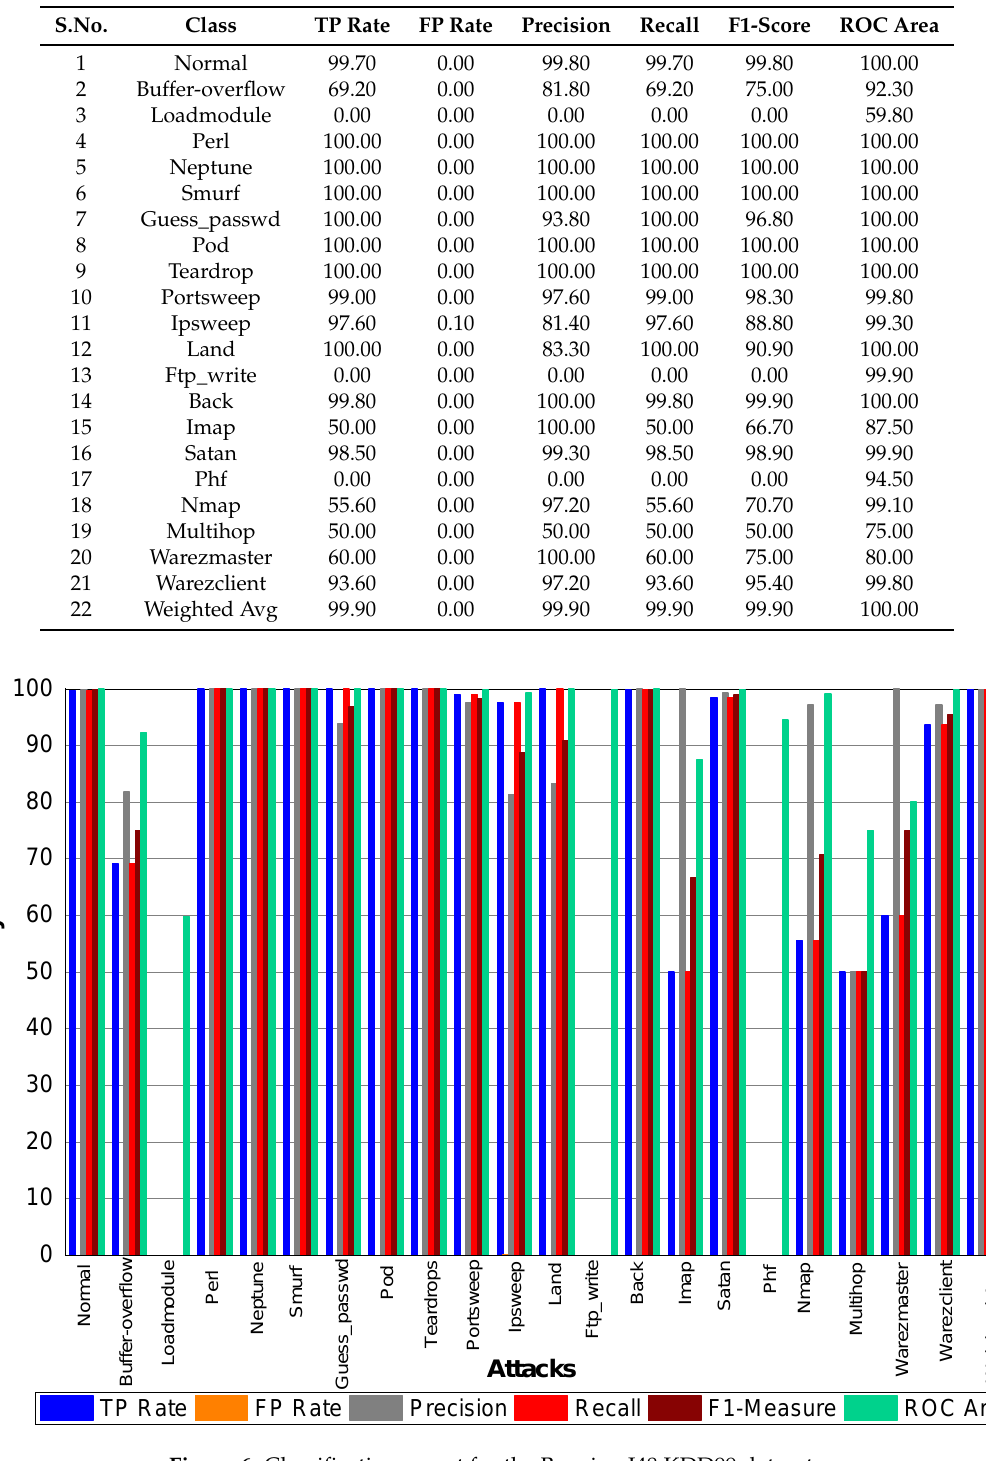
Figure 6. Classification report for the Bagging J48 KDD99